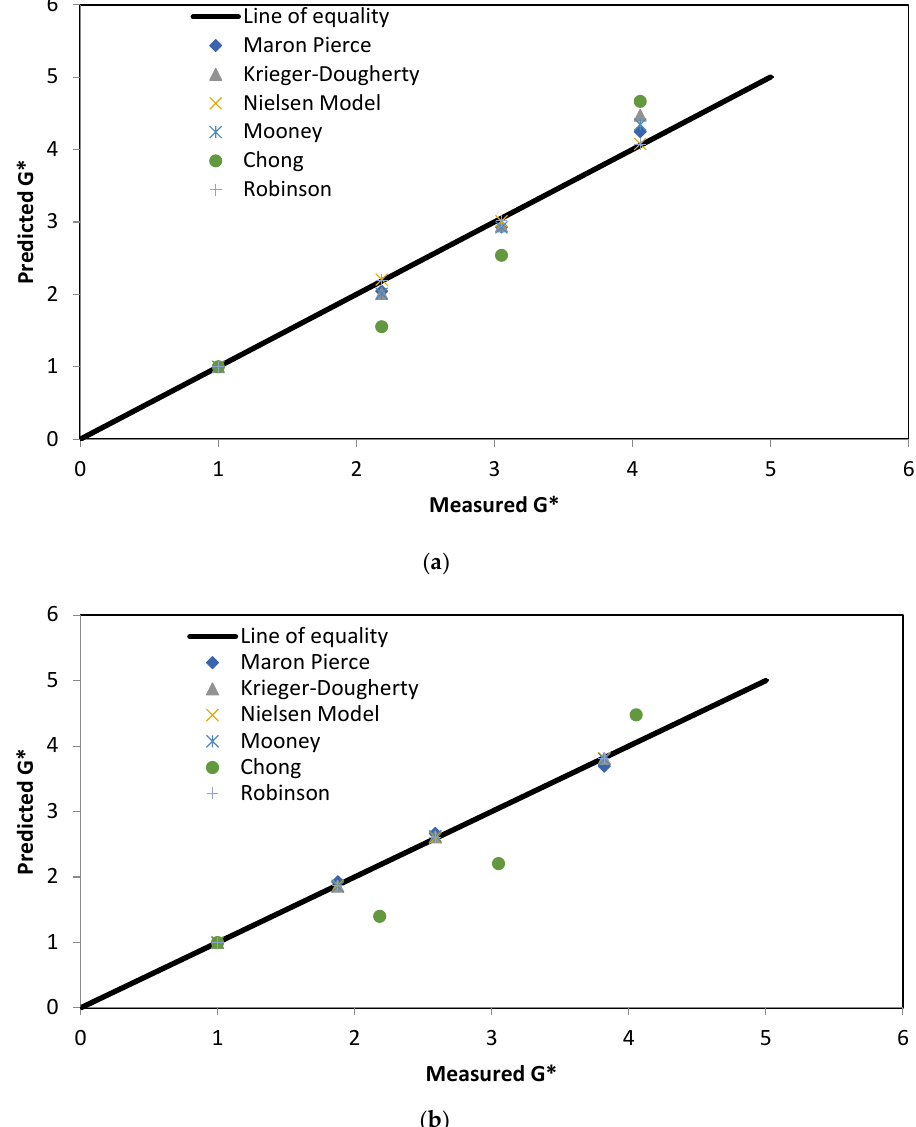
Figure 11. Line of equality graph for ( a ) limestone ( b ) granite. Table 5. Micromechanics models parameters.